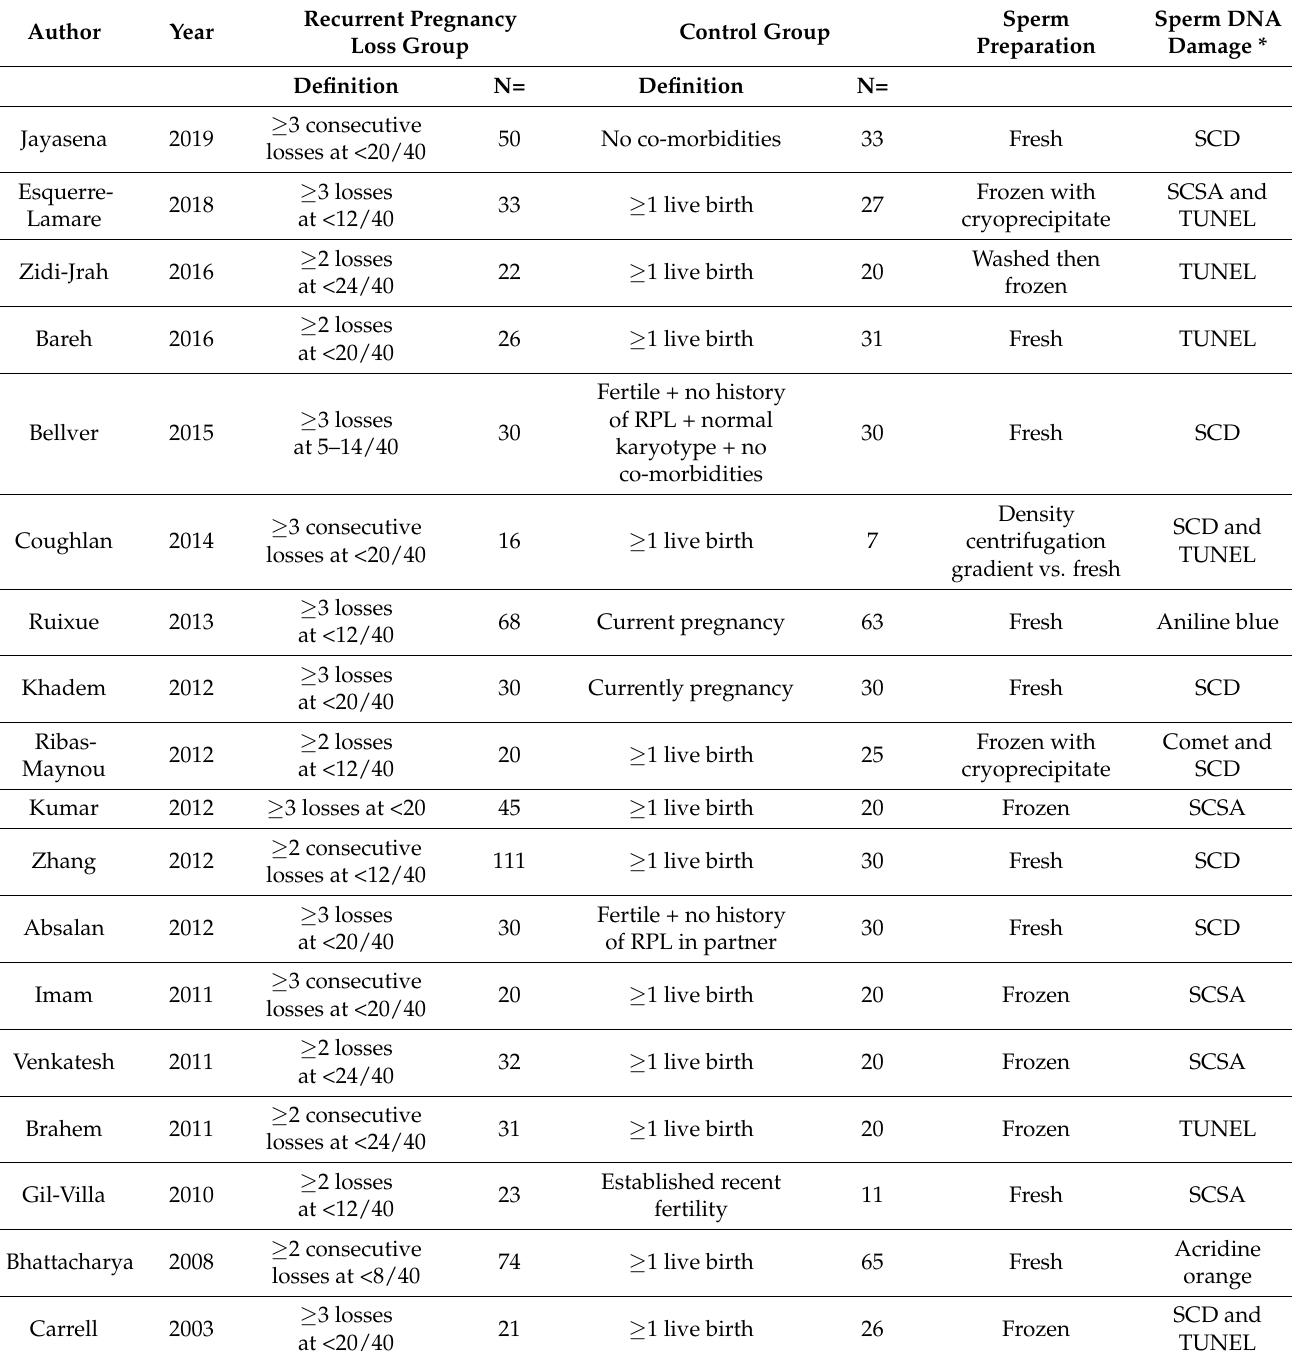
Table 2. Qualitative analysis of studies on recurrent pregnancy loss and sperm DNA